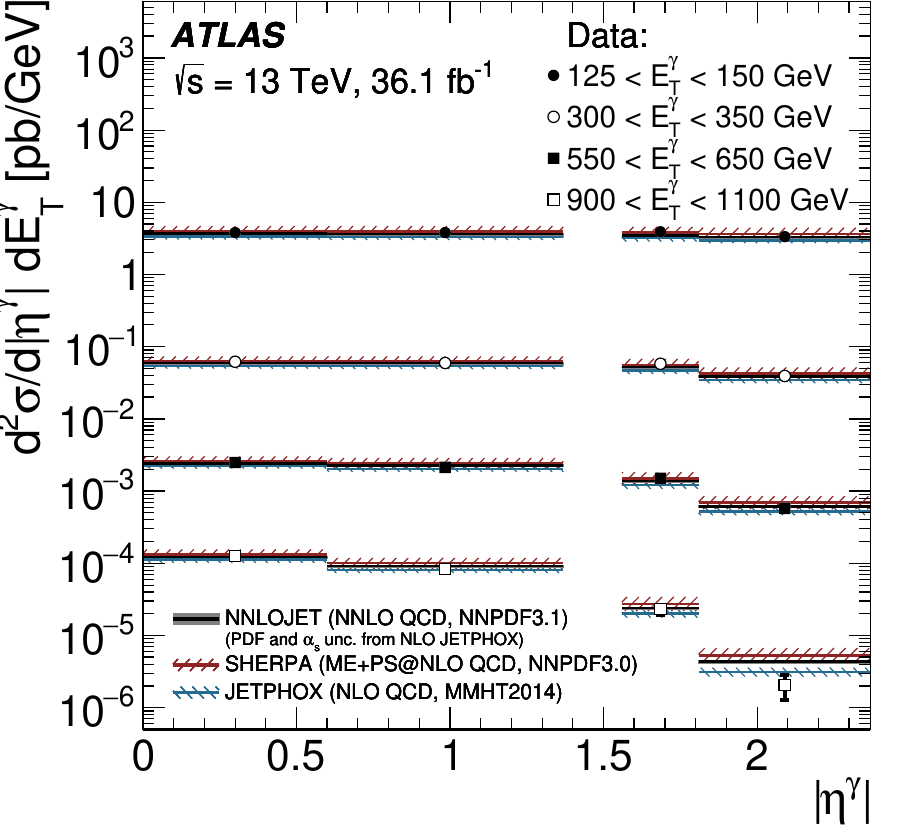
Figure 7 . The measured double-di(cid:11)erential cross section for isolated-photon production as a function of j (cid:17) (cid:13) j in 125 < E (cid:13) < 150 GeV (black dots), 300 < E (cid:13) < 350 GeV (open circles), T T 550 < E (cid:13) < 650 GeV (black squares) and 900 < E (cid:13) < 1100 GeV (open squares). The NLO T T pQCD prediction from Jetphox , the ME+PS@NLO QCD prediction from Sherpa 2.2.2 and the NNLO QCD prediction from Nnlojet are also shown. The error bars represent the data statistical uncertainties and systematic uncertainties added in quadrature. For most of the points, the error bars are smaller than the marker size and, thus, not visible. The bands represent the theoretical uncertainty associated with the predictions; in the case of Nnlojet , the uncertainties due to the PDFs and (cid:11) s are estimated at NLO with Jetphox